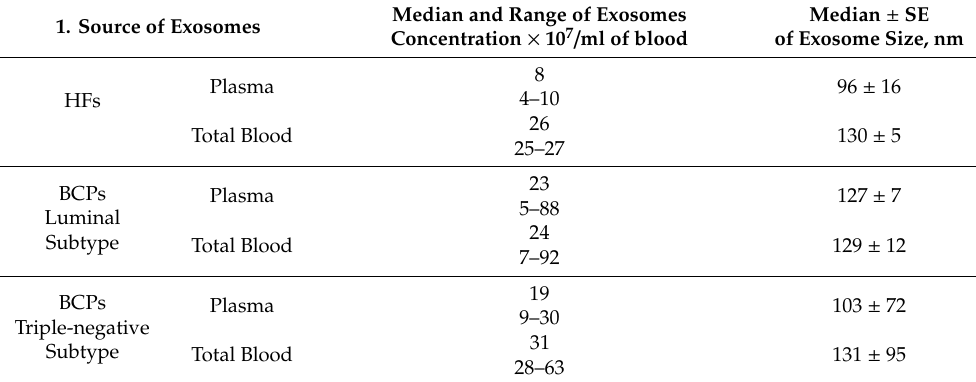
Table 2. Concentration and Size-distribution of Plasma Exosomes and Total Blood Exosomes Isolated from the Blood of HFs and BCPs. Data of NTA (Malvern, NS-300).